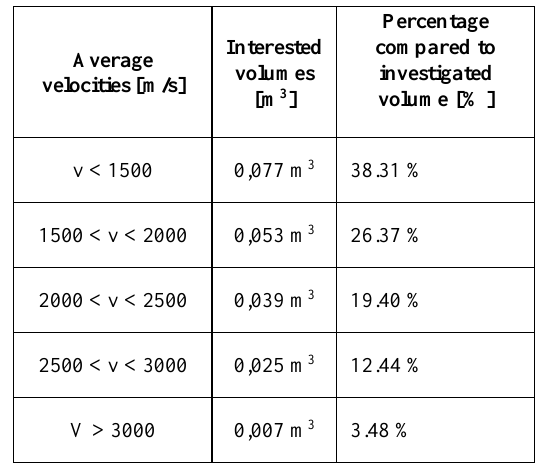
Figure 45. Improved representation of average velocities in the VOI of the Ramessid statue.